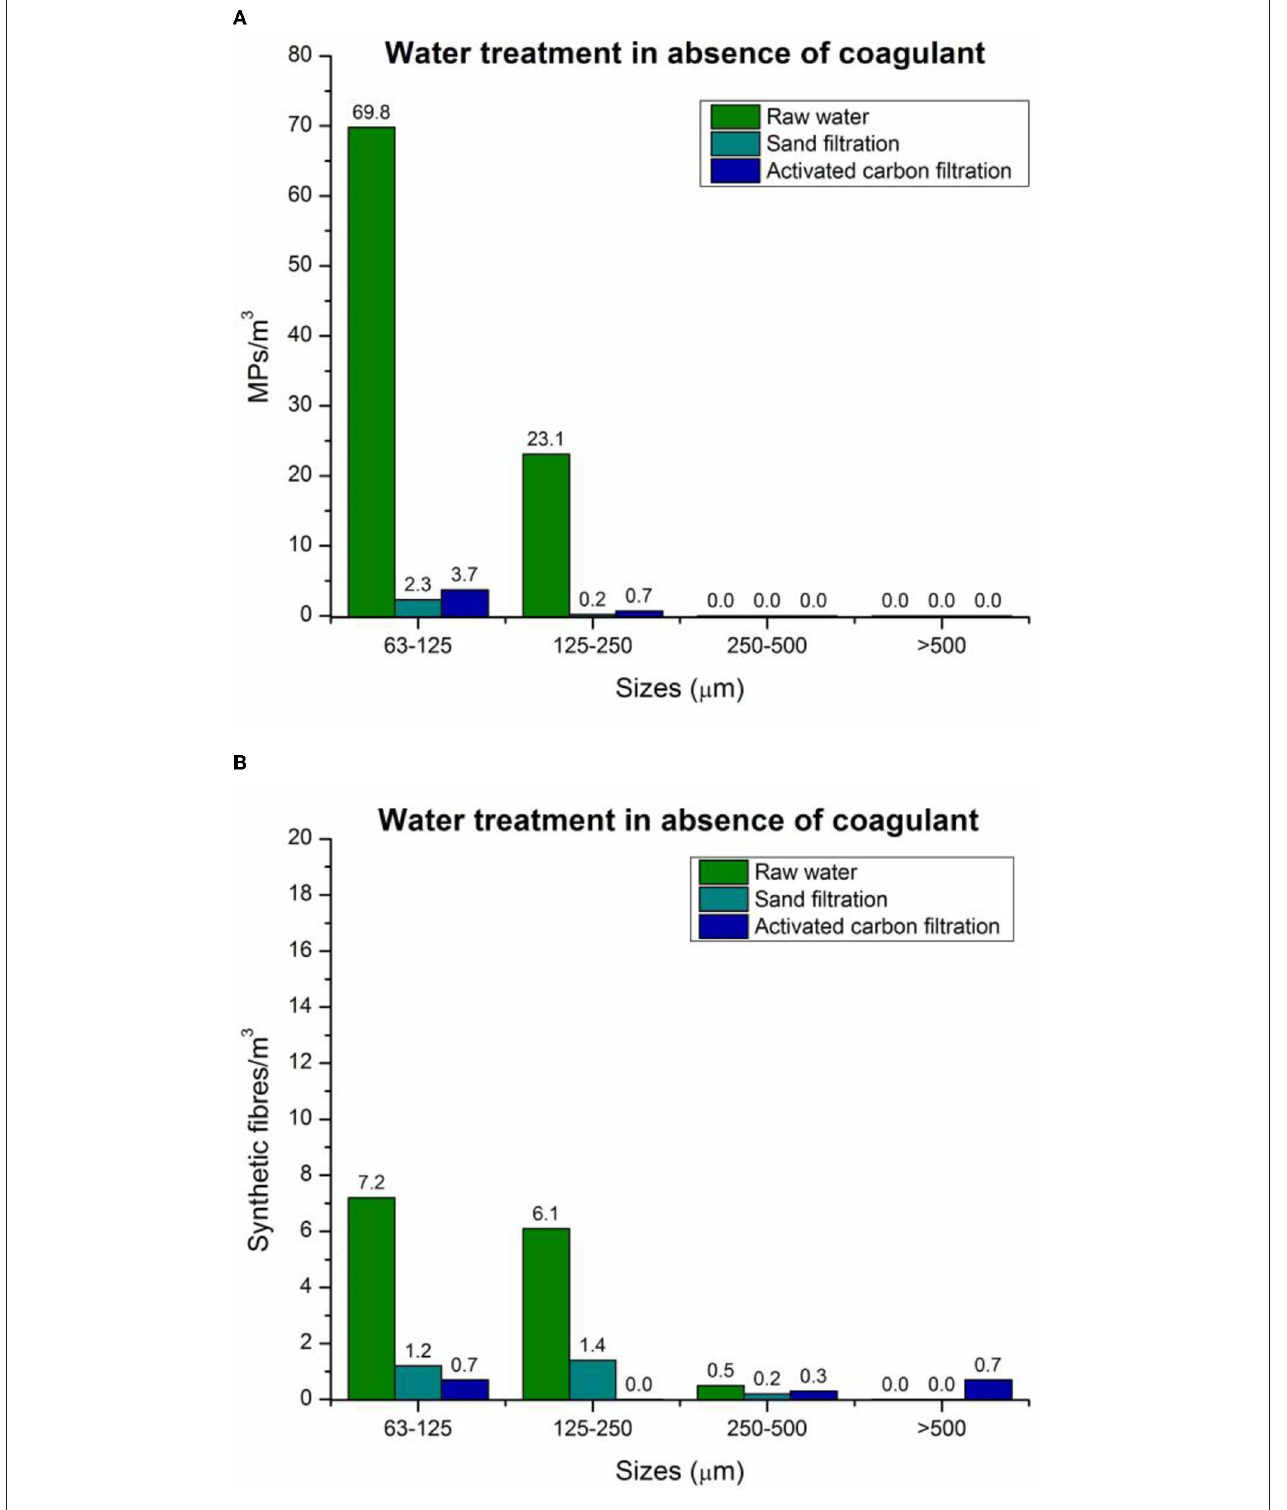
FIGURE 5 | Size distribution concentrations of MPs (A) and synthetic fibres (B) in absence of coagulant.